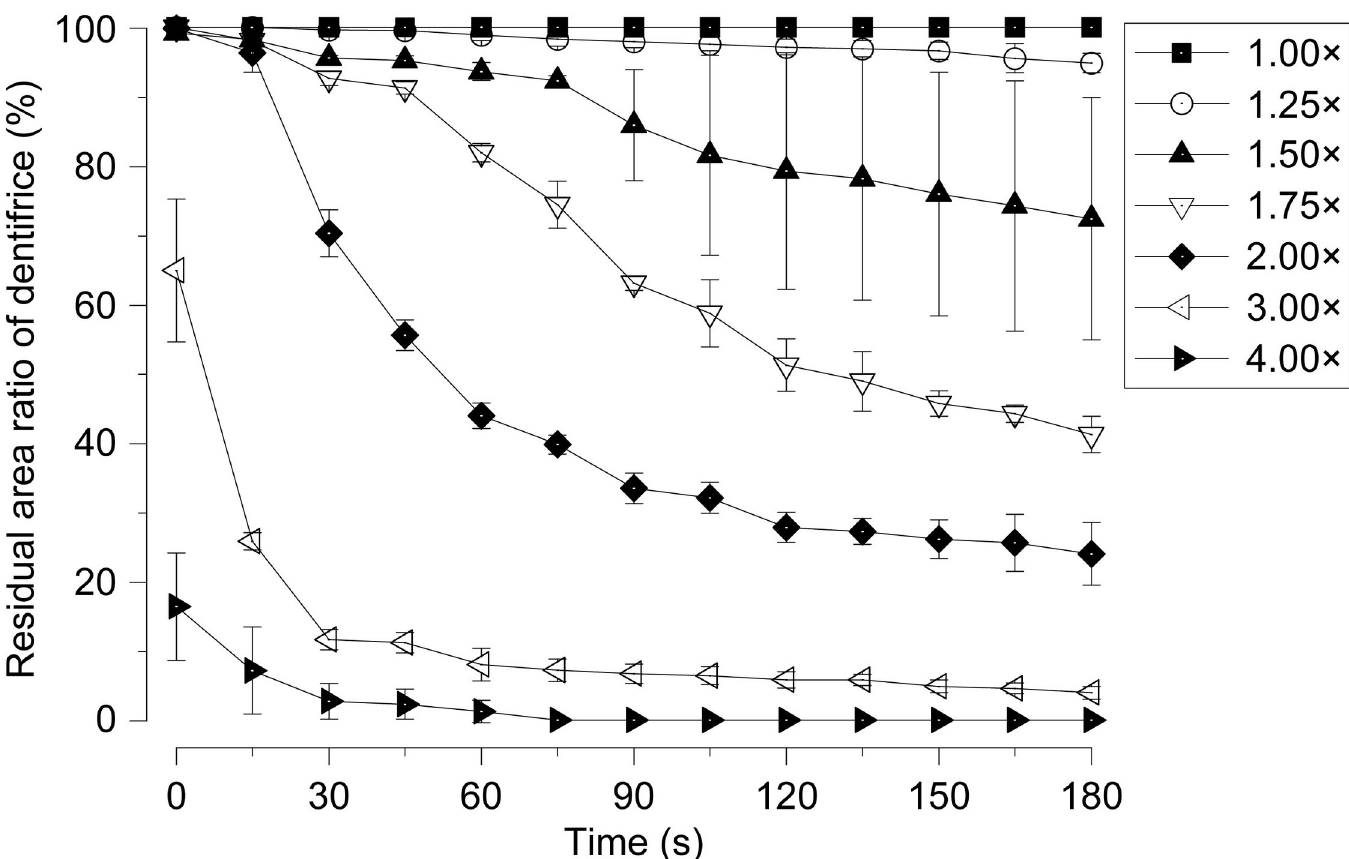
Fig 4. Time transition of the residual area ratio of the dentifrice for each dilution ratio. The black square indicates dentifrice with a concentration of 100% (1.00 × ). White circles: 80% (1.25 × ), black triangles: 67% (1.50 × ), white inverted triangles: 57% (1.75 × ), black diamonds: 50% (2.00 × ), white left-pointing triangle: 33% (3.00 × ), black right-pointing triangle: 25% (4.00 × ). Data for each group are presented as the mean ± standard deviation (SD) of three replicates (n = 3).